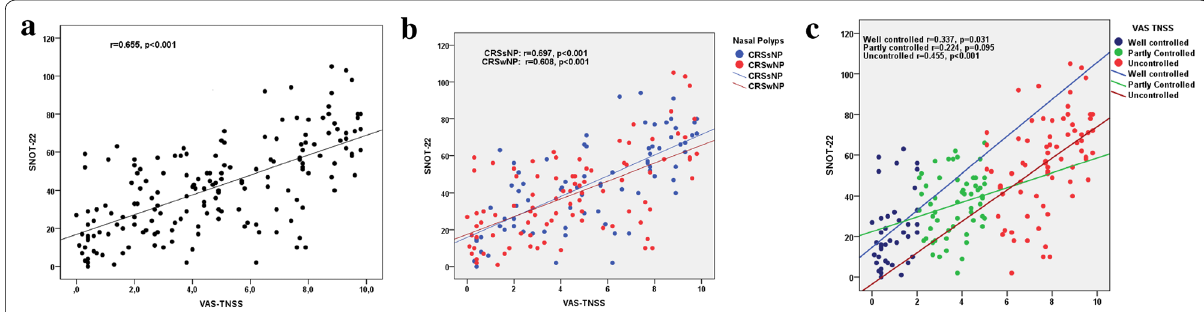
Fig. 1 a Scatterplot of the correlation between SNOT-22 score and VAS-TNSS in CRS, b scatterplot in the two major phenotypes (CRSsNP, CRSwNP), c scatterplot of the correlation in different levels of disease control